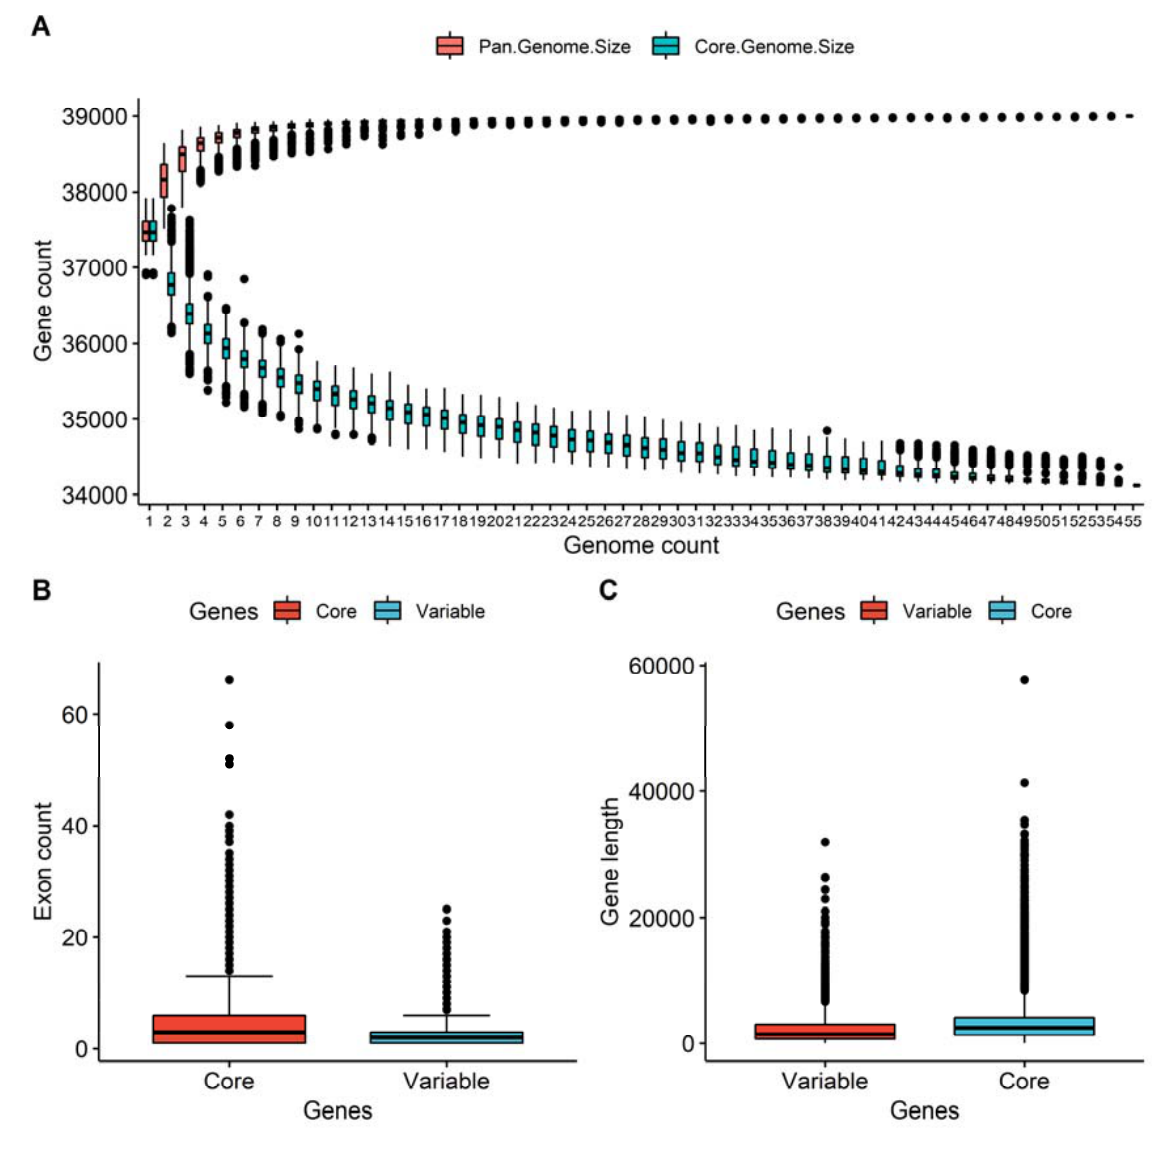
Figure 1. Gene distribution in the rice pan-genome. ( A ) The growth model of pan-genome genes and core genes. ( B ) Distribution of exon counts among the core and variable genes. ( C ) Distribution of the length of genes among the core and variable genes.